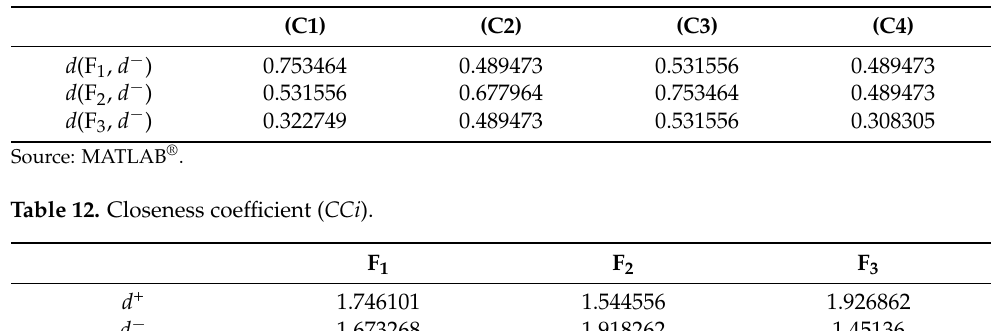
Table 11. Distance between alternatives from FNIS.